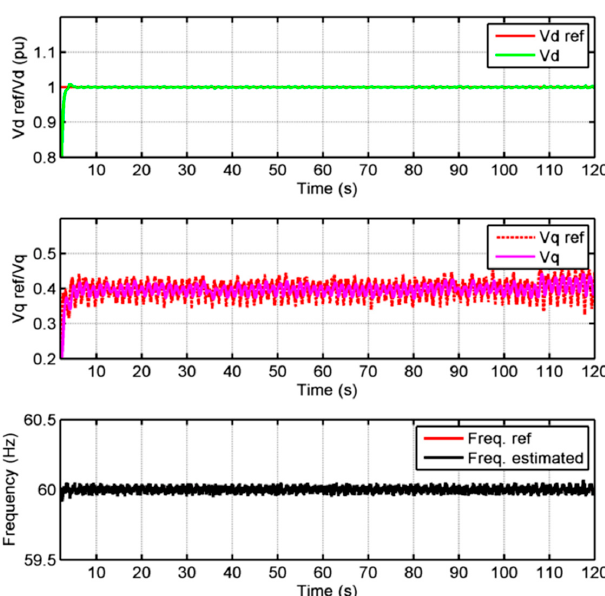
Figure 10. Load voltage regulation and frequency estimation.